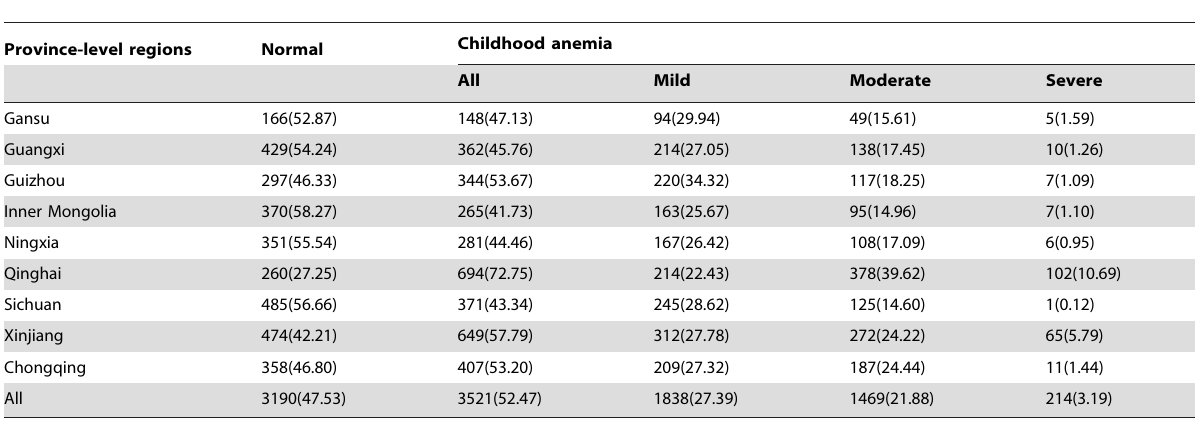
Table 2. Severity of anemia among children 36 months old in rural western China.